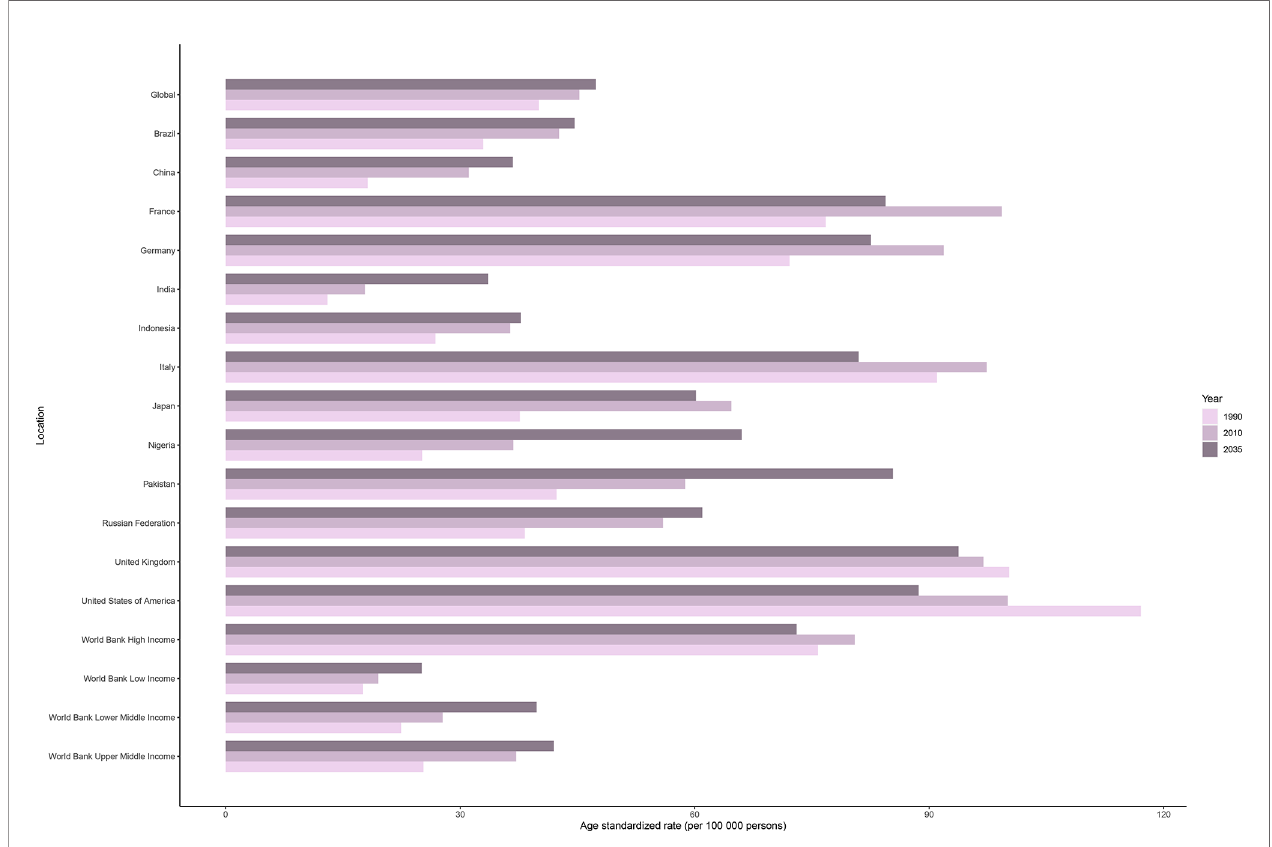
FIGURE 5 | Age-standardized incidence rates of female breast cancer in 1990 and 2010, and predicted incidence rates in 2035 worldwide, in four World Bank income regions, and in 13